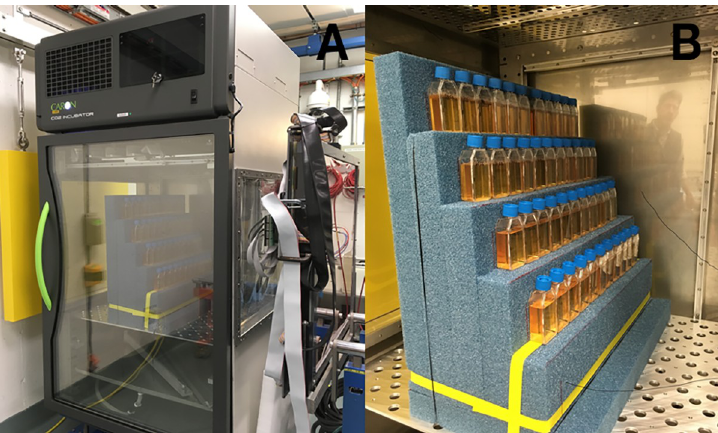
Fig 13. Modified incubator for use in beamline (A) with a holder that can accommodate up to 15 T75 flasks in a 3 × 5 array or 44 T25 flasks (B).